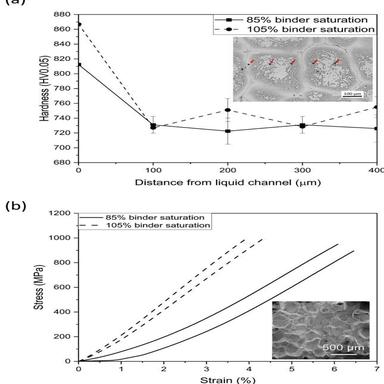
Hardness mapping (a) and tensile testing (b) on the 85% and 105% binder saturation samples. The inset in (a) shows the red arrows highlighting the indent locations and, (b) shows the representative fractograph indicating a brittle inter-granular failure in the 85% saturation sample. The fractograph was similar for the 105% sample and has not been shown for brevity.